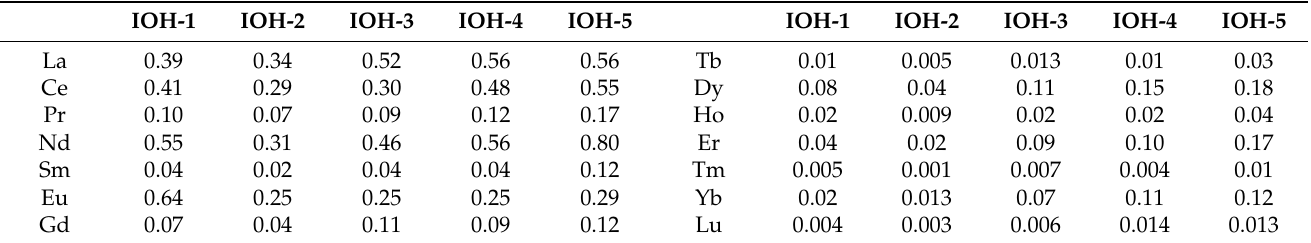
Table 2. Median REE contents of IOH types of the Pobeda-1 hydrothermal field,